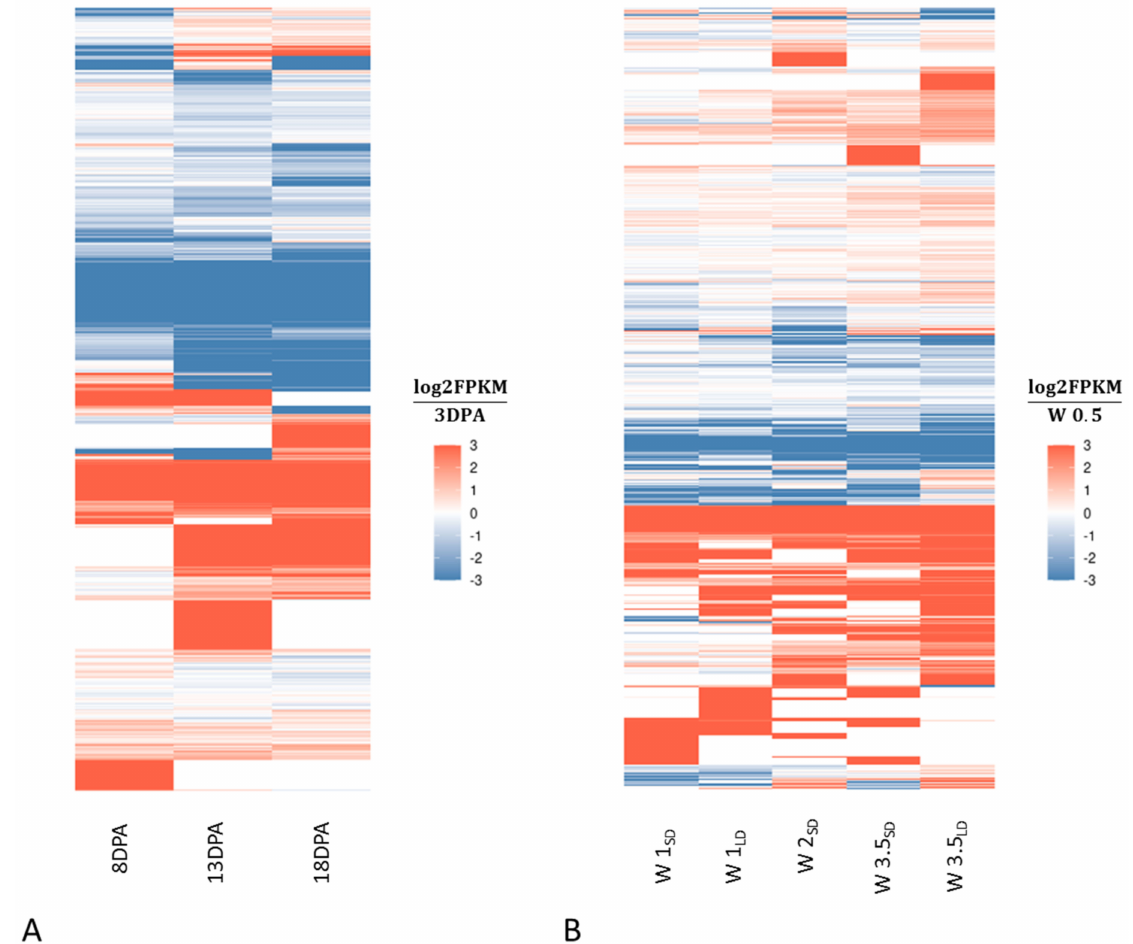
Figure 6. Changes in expression of lncRNAs in the developing grains in relation to 3 DPA stage ( A ) and in the developing shoot apices in relation to stage W 0.5 ( B ); red color indicates up-regulation and blue color indicates down-regulation of lncRNA expression; SD, short day conditions; LD, log day conditions. Heatmaps were drawn based on normalized log 2 FPKM values from all sample